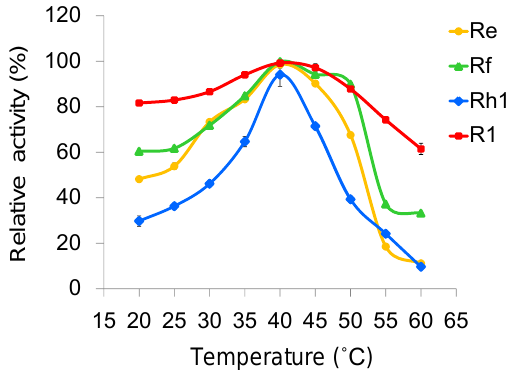
Figure 5. Effect of temperature on the enzymatic activity of UGT109A1.